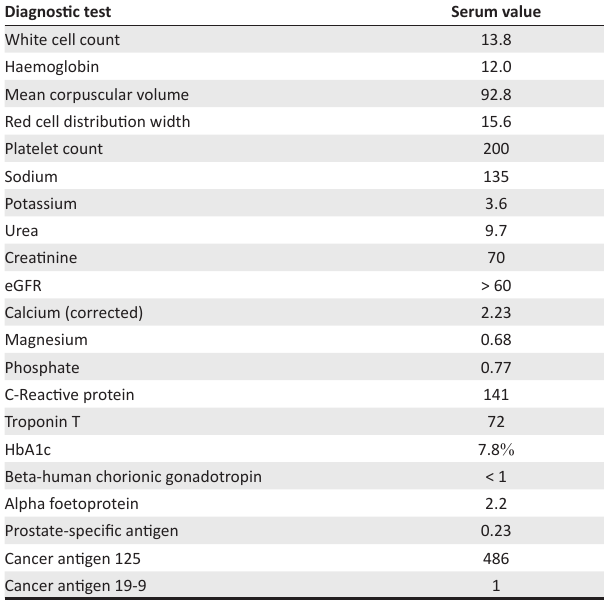
TABLE 1: Initial laboratory serum